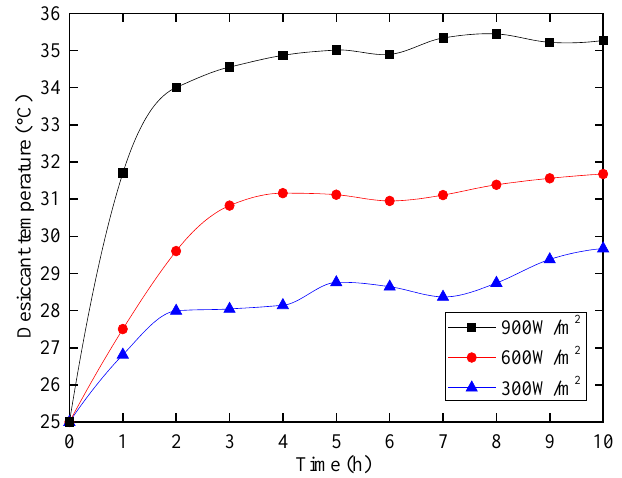
Figure 9. The variation of the temperature of the solid desiccant modules with time.